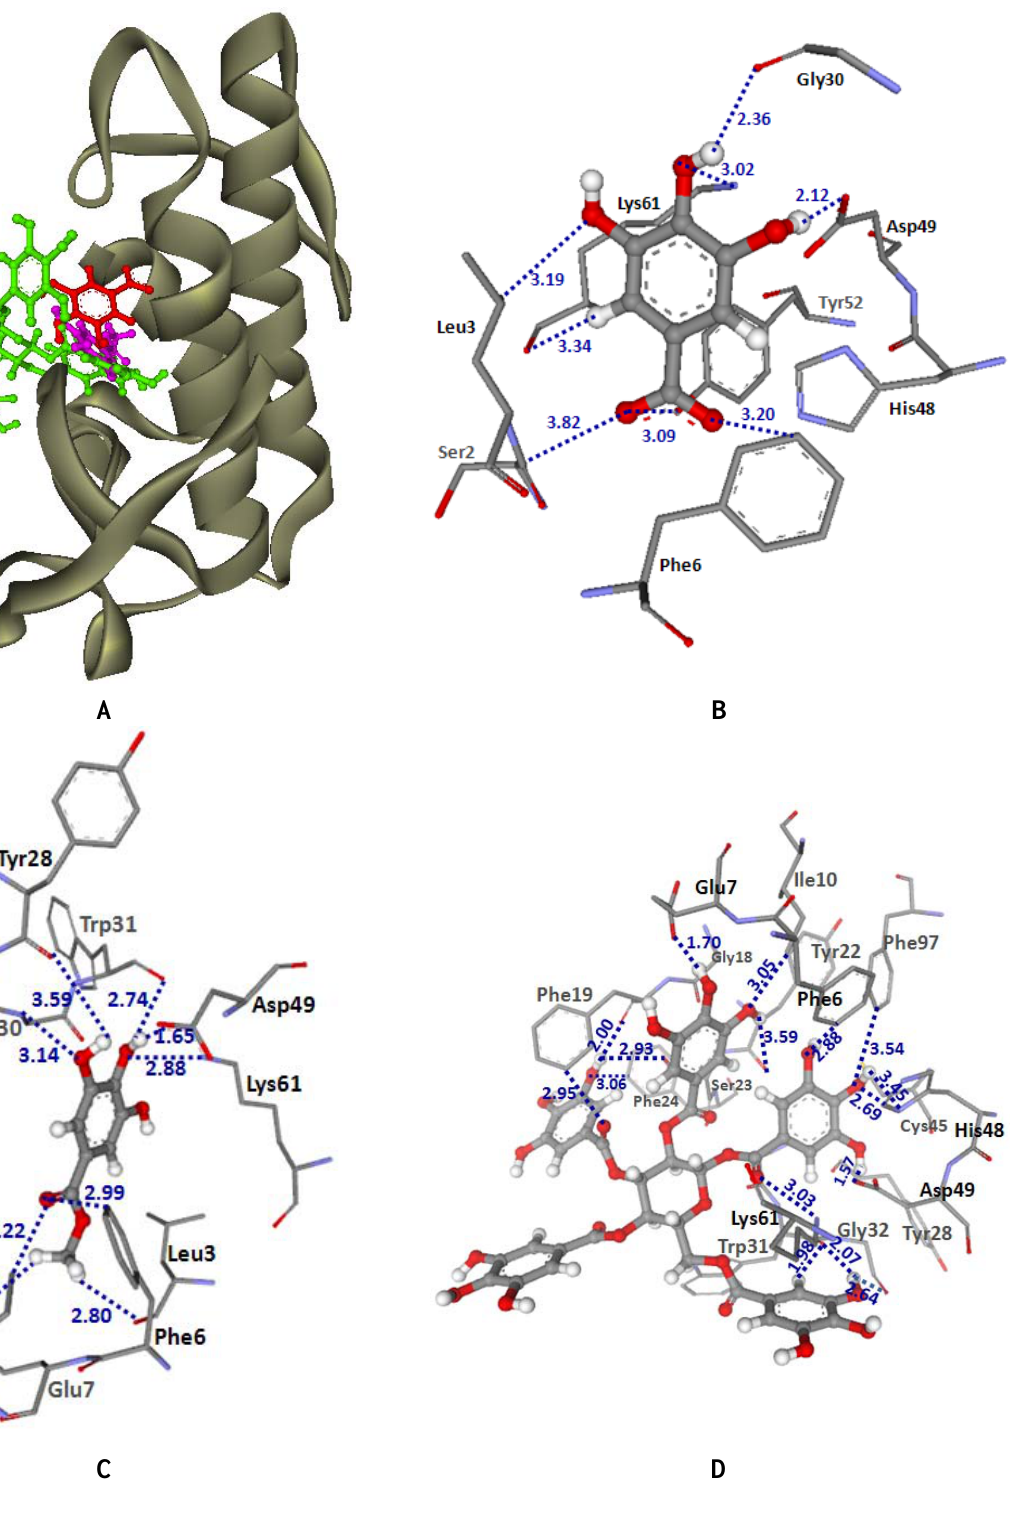
Figure 5. (A) Docked conformation of ligand structures in PLA MG: Margenta and PGG: Green). (B–D) Distances (in Å) between residues in PLA binding pocket and ligands: GA (B), MG (C) and PGG